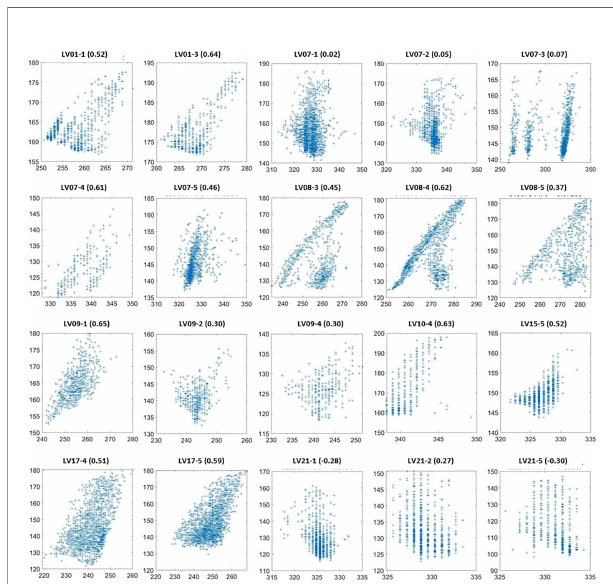
FIGURE 7 | SI (vertical axes in mm) as a function of Belly (horizontal axes in mm) for the sessions with the lowest 20 SI-Belly correlation coef fi cients. Figure titles include patient ID and Session #. Correlation coef fi cients are in